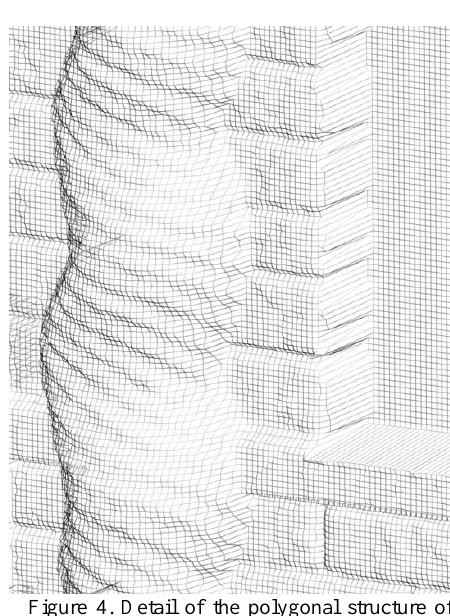
Figure 4. Detail of the polygonal structure of the